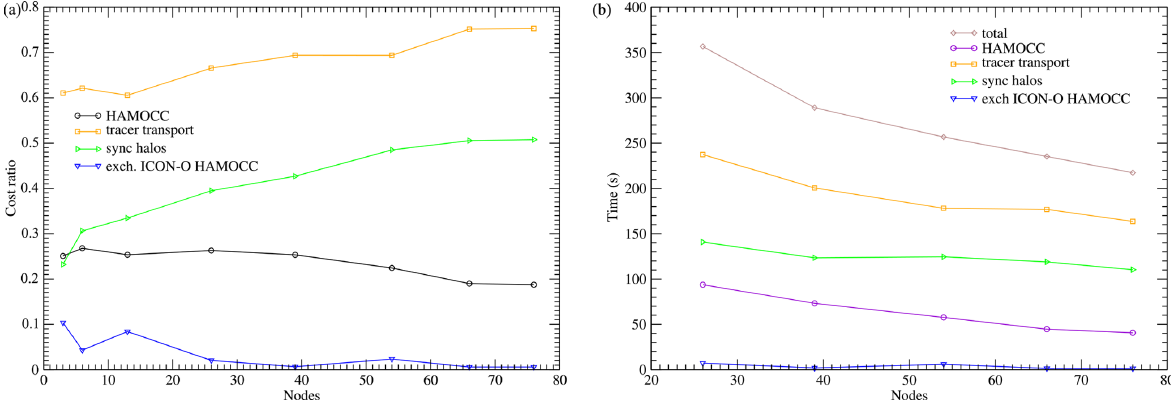
Figure 12. (a) Relative costs of the HAMOCC components in the concurrent 160km setup. (b) Run times of the HAMOCC